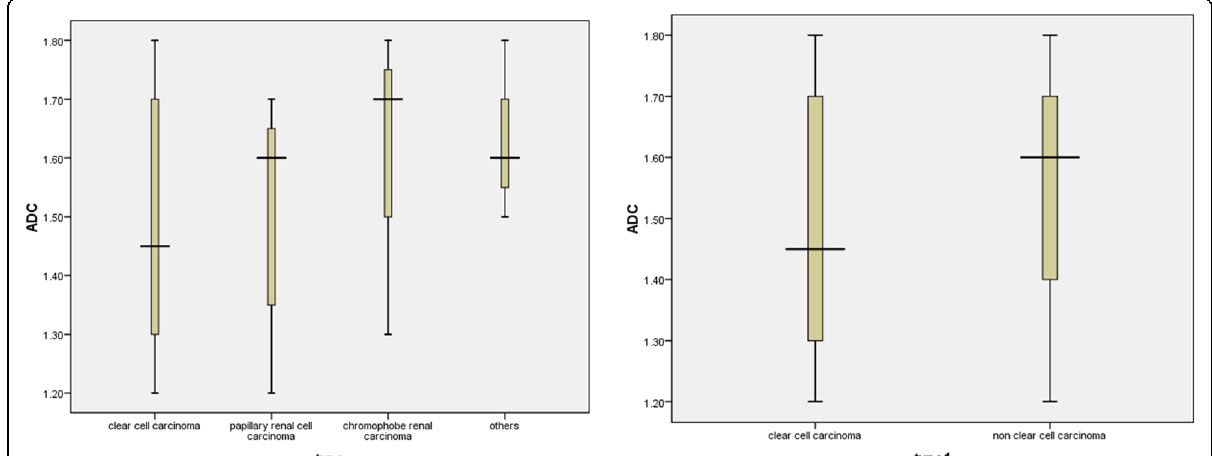
Fig. 4 Distribution of ADC values by histopathology group. Box plot showing ADC values (expressed as millimeter squared per second) for different histopathological types of RCC (figure on the right side is clear RCC versus papillary, chromophobe, and non-classified RCC, and figure on the left side is clear RCC versus non-clear